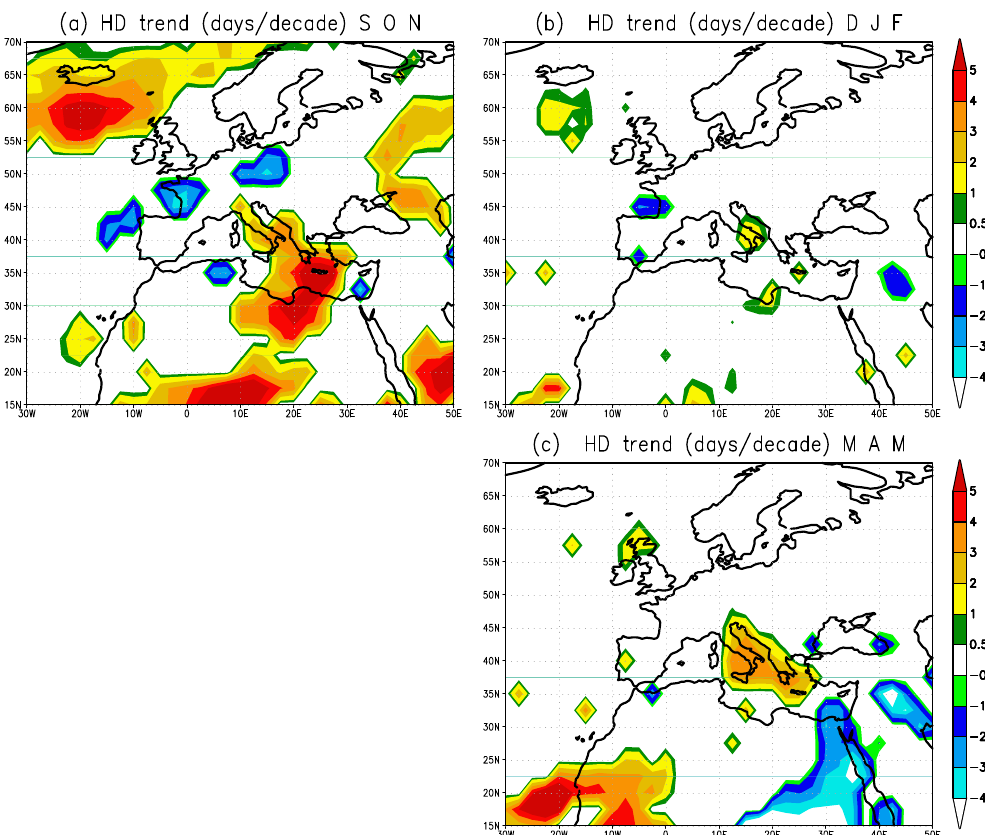
Figure 5. Linear trend in the frequency of occurrence of humid days (in daysdecade − 1 ) during 1979–2013 according to the NNRP data: (a) September–November; (b) December–February; (c) March–May (Fig. 13 in Krichak et al., 2015; used with permission from